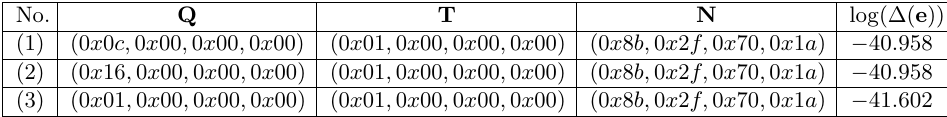
Table 5: The best byte-wise masks ( Q , T , N ) for the linear approximation (4)